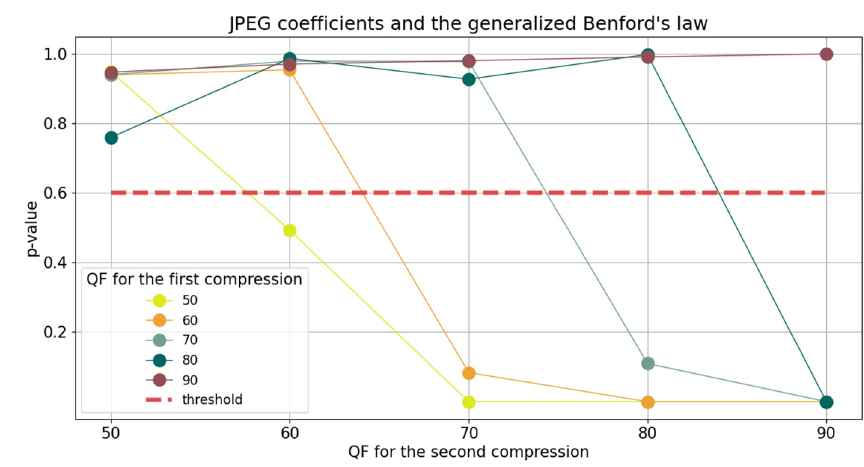
Figure 16. The JPEG coefficients compared to the GBL, using the G channel.